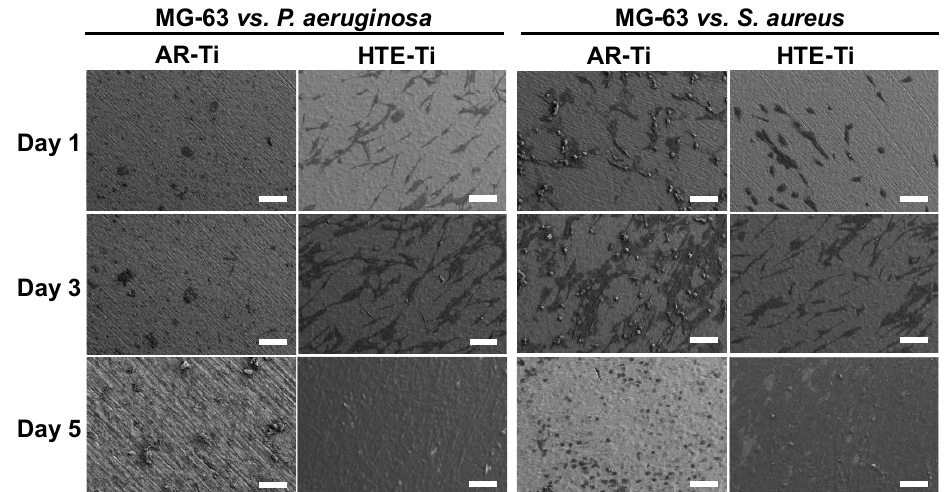
Figure 2. Attachment and proliferation of MG-63 cells on pre-infected titanium surfaces during a 5-day incubation period. Representative SEM images show that on the HTE-Ti surfaces, cells were able to grow successfully, achieving confluency over a 5-day incubation period, whereas the growth of the MG-63 cells on flat, titanium surfaces (AR-Ti) was inhibited due to the colonization of the surface by pathogenic bacteria (scale bar = 20 µm). Materials 2018 , 11 , x FOR PEER REVIEW